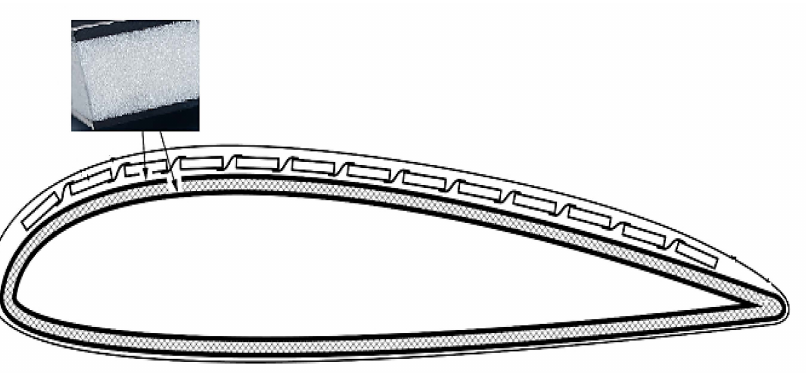
Figure 1. Transversal section through the wing with detailed sandwich structure: carbon fibre fabric, aerogel, carbon fibre